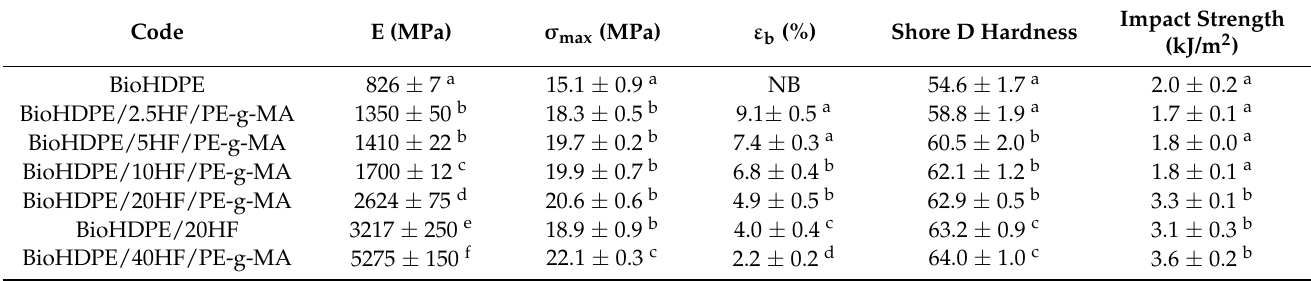
Table 2. Summary of mechanical properties of the BioHDPE-hemp fiber composites in terms of tensile modulus (E), maximum tensile strength ( σ max ), elongation at break ( ε b ), Shore D hardness and impact